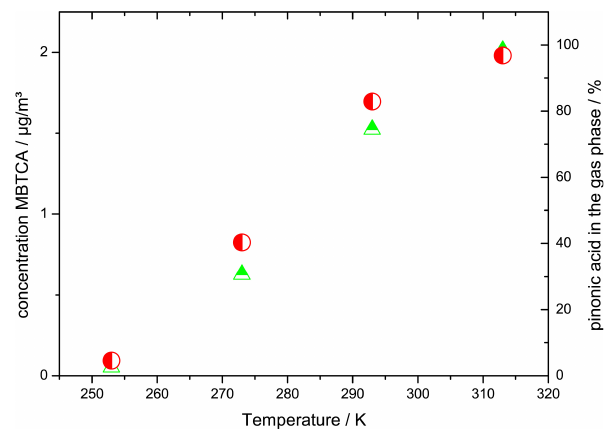
Fig. 4. Concentration of MBTCA (triangle) derived from α -pinene SOA aging at different temperatures; magnitude of gas phase frac- tion of pinonic acid (circles) at different